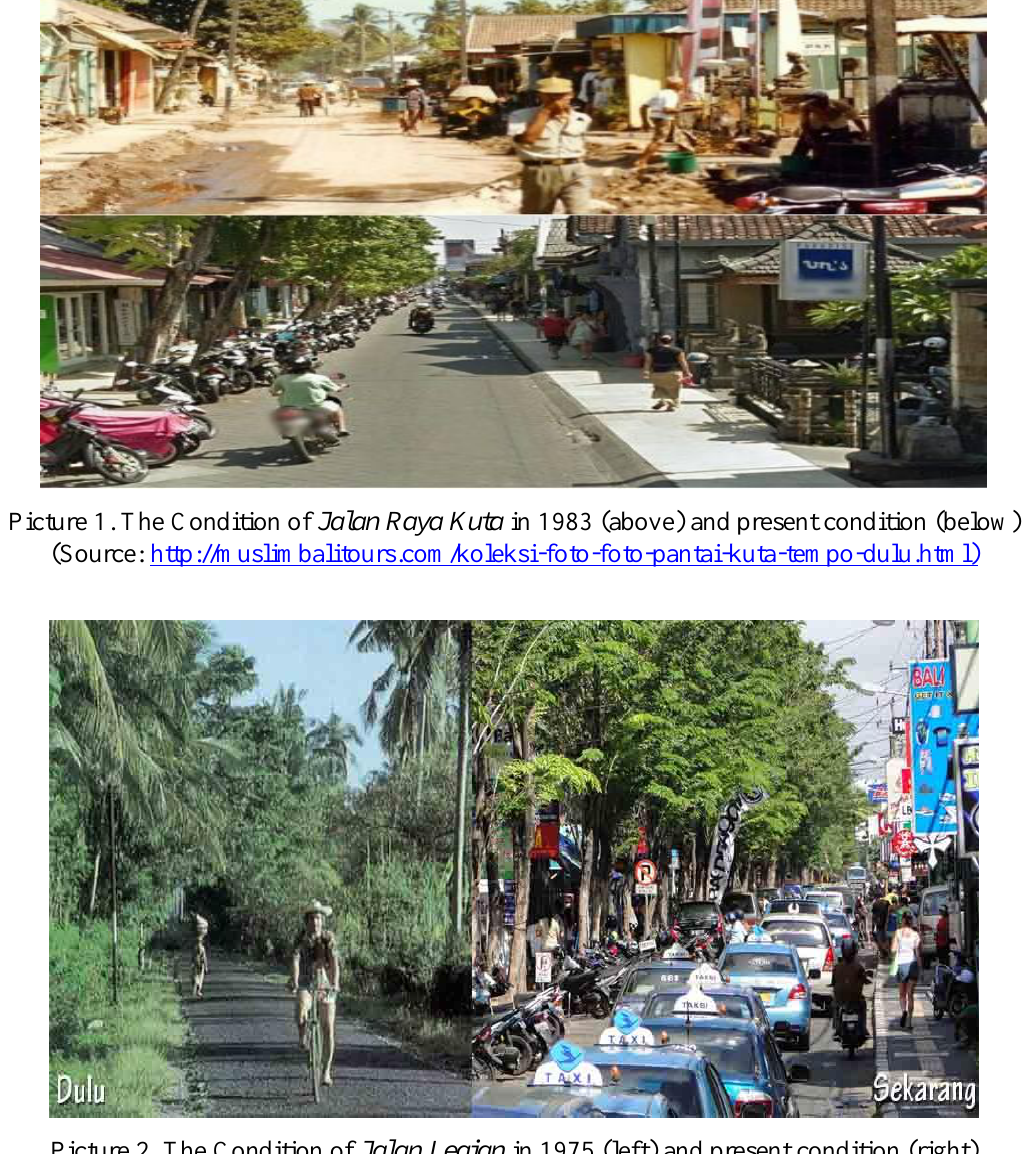
Picture 2. The Condition of Jalan Legian in 1975 (left) and present condition